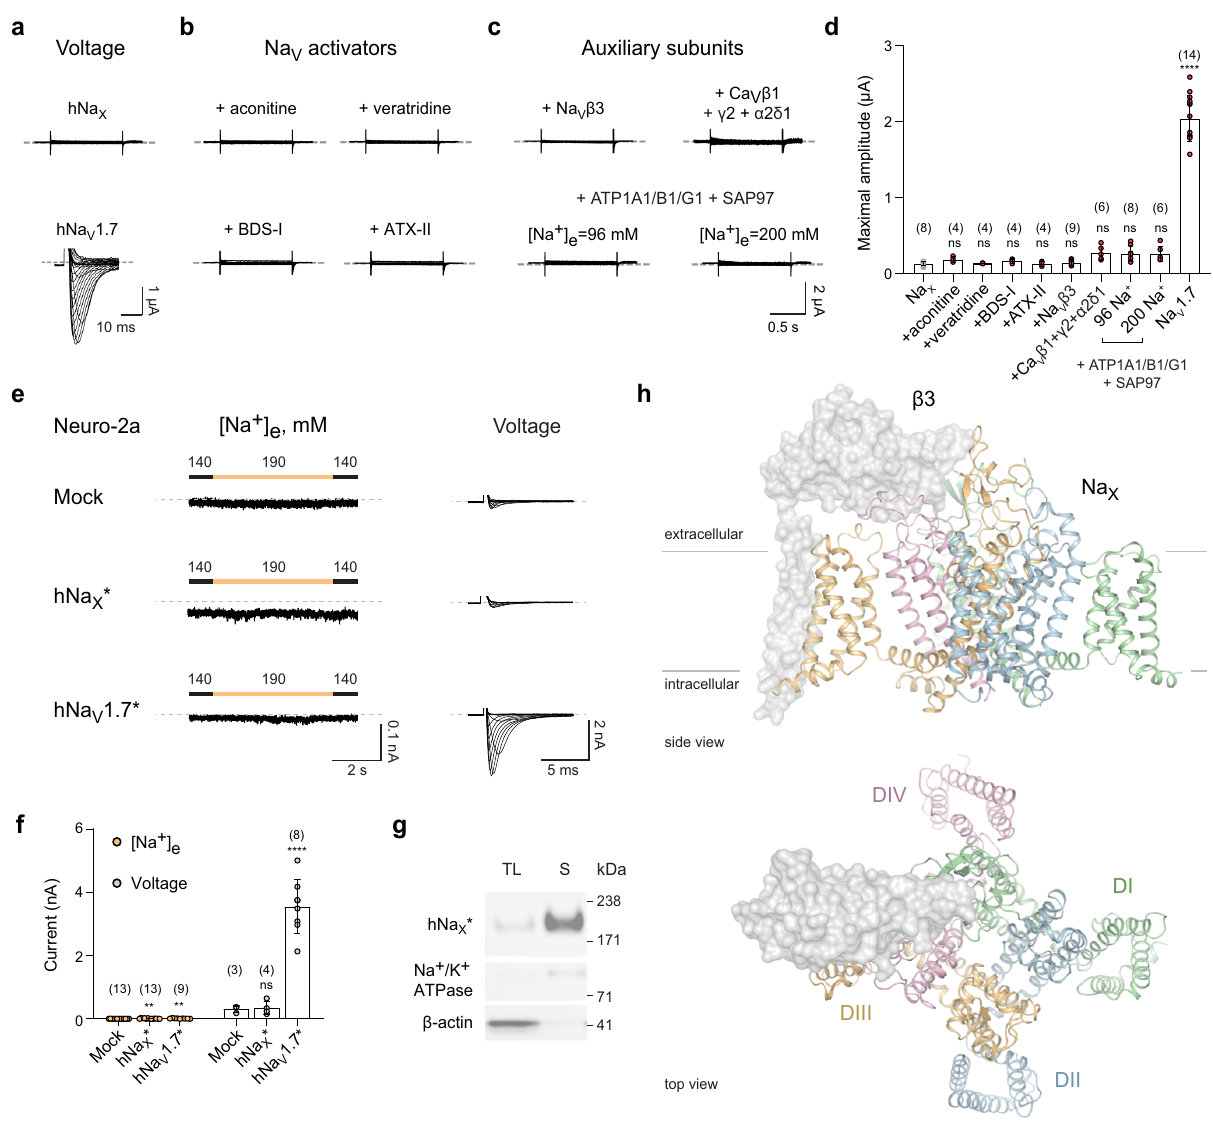
Fig. 1 Characterization of and overall structure of human Na X . a Representative currents from Xenopus laevis oocytes expressing human Na X or Na V 1.7. Na X : steps between + 80 to − 100 mV, in 20 mV increments from a HP of 0 mV; Na V 1.7: depolarizing steps between − 80 and + 65 mV, in 5 mV increments, from a HP of − 100 mV. b Representative currents from oocytes expressing Na X in response to extracellular application of indicated compounds (BDS-I Blood depressing substance I, ATX-II Neurotoxin 2). Voltage protocols as above. See Methods for concentrations of compounds tested. c Representative currents from oocytes expressing Na X and co-expression of Na V or Ca V channel auxiliary-subunits, Na + /K + -ATPase subunits and synapse-associated protein 97 (SAP97), and in the presence of the indicated extracellular Na + concentration. Voltage protocols as above. d Data summary of independent experiments performed as in parts a – c . Data are shown as mean ± SD; ns not signi fi cant; **** p < 0.0001; one-way ANOVA with Dunnett ’ s test (against Na X ). Exact p -values and statistical parameters are provided in Source Data. Numbers of biological replicates ( n ) are indicated. e Representative currents from murine Neuro-2a cells expressing human Na X or Na V 1.7 in response to changes of the extracellular Na + concentration (HP = − 60 mV), as indicated, or voltage: depolarizing steps between − 60 to + 60 mV, in 10 mV increments from a HP of − 100 mV. f Data summary of independent experiments performed as in parts e . Data are shown as mean ± SD; ns not signi fi cant; * p < 0.05; ** p < 0.01; **** p < 0.0001; one-way ANOVA with Dunnett ’ s test (against mock-transfected cells). Exact p -values and statistical parameters are provided in Source Data. Numbers of biological replicates ( n ) are indicated. g Western blots of total lysate and surface fraction of proteins extracted from Neuro-2a cells probed for the indicated proteins. Data represent three independent biological replicates. h Side and extracellular view of the β 3-Na X channel complex. Approximate membrane boundaries are indicated. DI, DII, DIII, and DIV are colored in green, blue, orange, and pink, respectively, with the β 3-subunit in gray surface